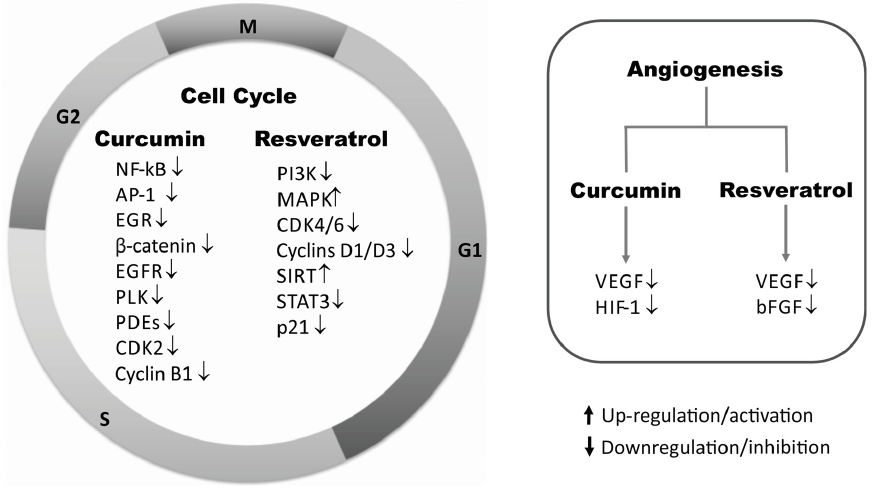
Figure 1. Effects of curcumin and resveratrol in cellular proliferation and